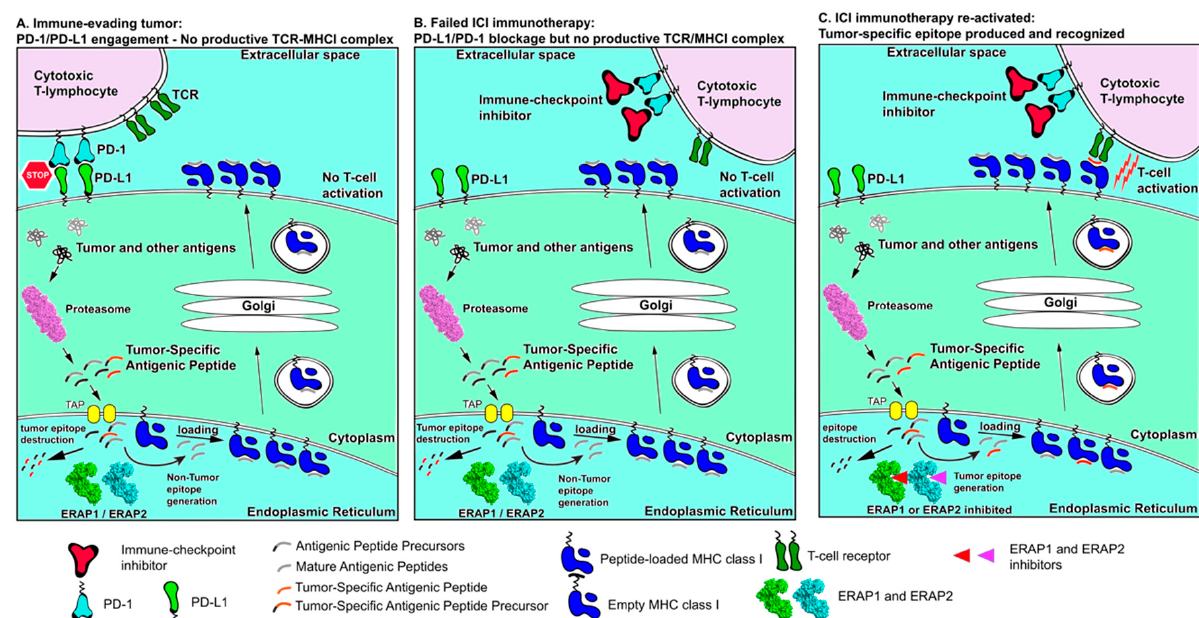
Figure 4. Schematic representation of antigen processing and presentation in cancer immune evasion and immune re- activation by ICIs and manipulation of intracellular antigen processing. ( Panel A ) tumor antigens are processed by the proteasome but then destroyed by ER aminopeptidases ERAP1 or ERAP2 resulting in lack of presentation on the cell surface. Overexpression of PD-L1 on the cancer cell surface downregulates cytotoxic T-lymphocyte responses. Synergism between these two mechanisms results in efficient immune evasion by the tumor. ( Panel B ) Immune-checkpoint inhibitors can help activate T cells but lack of tumor antigen presentation limits cytotoxic responses. ( Panel C ) inhibition of ERAP1 and ERAP2 can help rescue tumor-associated antigenic peptides from destruction and promote their presentation, which, in combination with ICI treatment, can help re-activate T cell cytotoxic responses against the tumor.